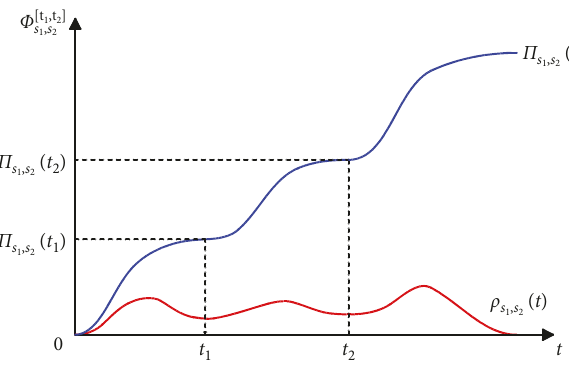
Figure 3: Cumulative passenger flow